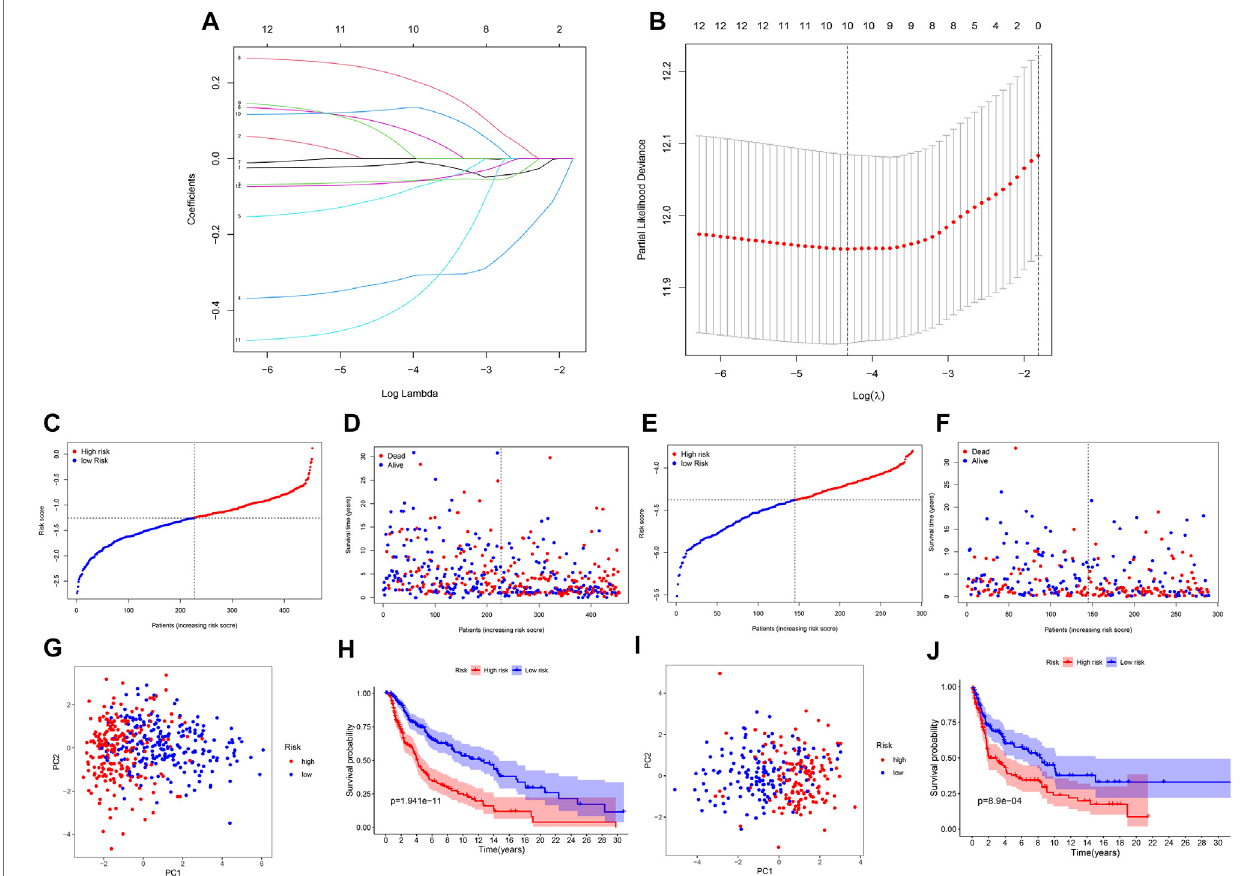
FIGURE 3 | A prognostic signature of NRG construction. (A) The 10 prognostic genes ’ LASSO coef fi cient pro fi les. (B) Partial likelihood deviation map. (C,F) Patients in TCGA and GEO cohorts ’ risk score distribution and survival status. (G,I) TCGA and GEO cohorts ’ PCA plots. (H,J) K-M survival curves for the training and validation